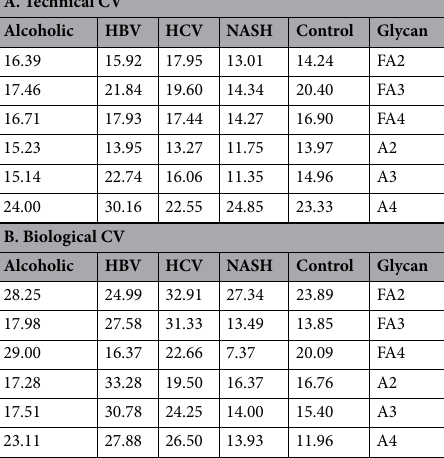
Table 1. Distribution of the average coefficients of variability (CV) for the indicated glycopeptide classes and disease groups across the entire study set. Duplicate measurements were performed for both the (A) technical and (B) biological CV measures.